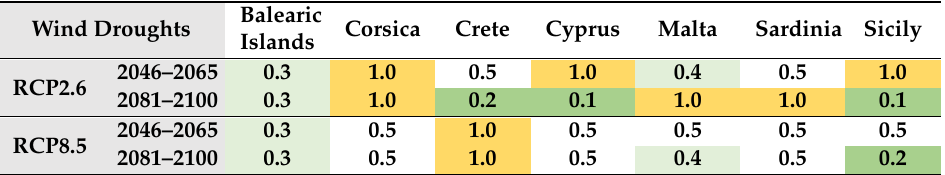
Table A3. Normalized uncertainty (Nu) for wind productivity droughts for each island, scenario and time period. Deep green cells: Nu = 0–0.2; Light green: Nu = 0.3–0.4; White: Nu = 0.5; Light yellow: Nu = 0.6–0.7; Deep yellow: Nu = 0.8–1. Nu is computed over land.